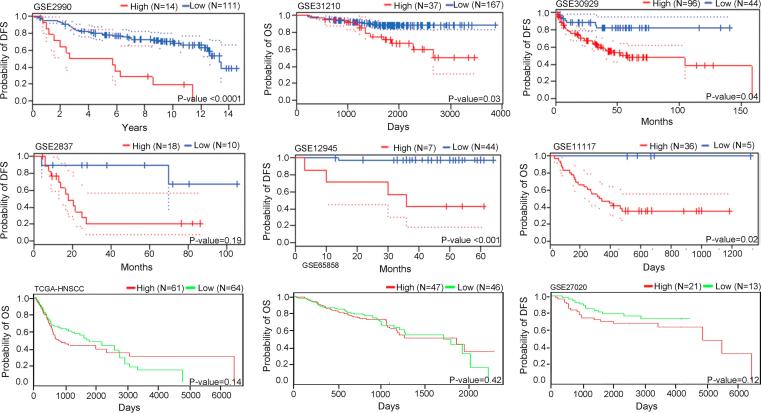
Kaplan-Meier survival curve disease-free survival and overall survival in various cancer types based on the level of MMP10 gene expression. Kaplan-Meier plot of DFS and OS analysis in HNSCC studies based on low and high MMP10 gene expression. The red and green lines denote high and low MMP10 expressing patient’s survival, respectively. The number of samples and median survival in each group is denoted. The log-rank test was applied to accesses the statistical differences in median survival and P-value ≤ 0.05 was considered as statistical significance. (For interpretation of the references to color in this figure legend, the reader is referred to the web version of this article.)